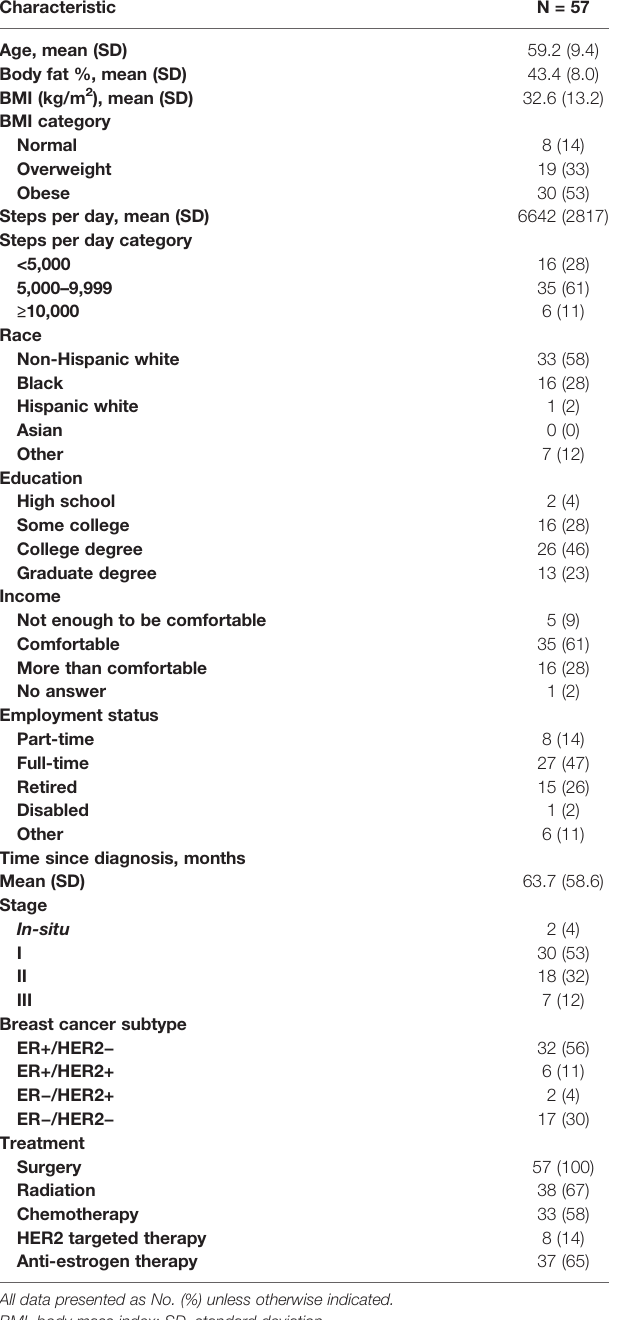
TABLE 1 | Baseline characteristics of the evaluable population.